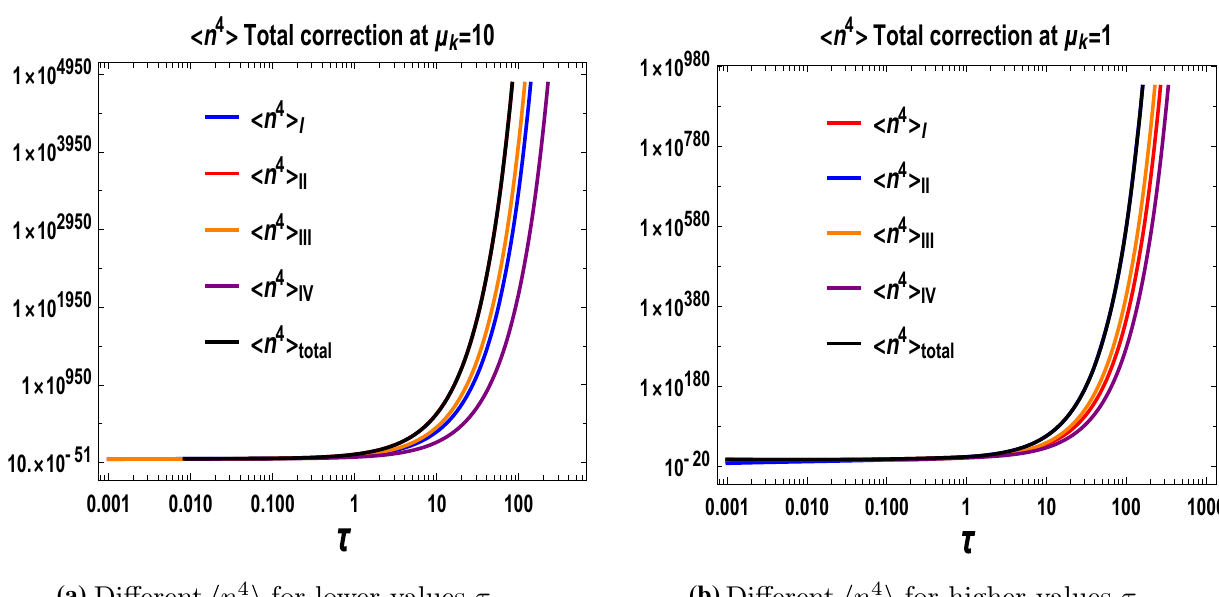
Fig. 51 Log plot of Time dependent behaviour of the Fourth moment (cid:14) n 4 (cid:15) for different fixed values of the parameter μ k